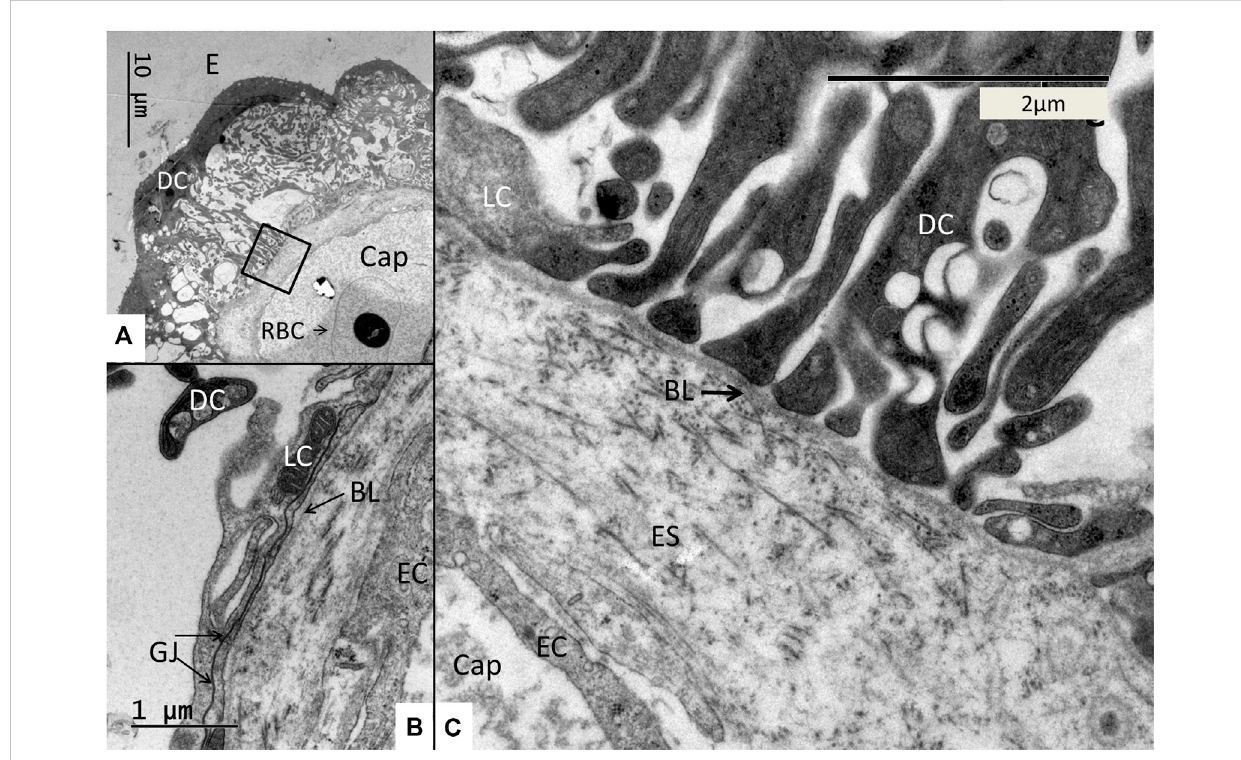
FIGURE 10 (A) Medium-power electron micrograph showing the SV epithelium closely associated with an intra-epithelial capillary. The capillary contains a nucleated red blood cell (RBC). Framed area is magni fi ed in (C) . (B) Higher magni fi cation shows the pericapillary region with light cells (LC) adhering to a thin basal lamina (BL). The light cells are connected with extensive gap junctions (GJ). There is a space between the endothelial cells (EC) and the basal lamina (BL). This space contains connective tissue fi bers. (C) Higher magni fi cation shows podocyte-like, dark cells (DC) projections adhering to the basal lamina (BL) and light cells (LC) surrounding the capillary (Cap) endothelium. There is a space containing extra-cellular matrix and thin connective tissue fi bers around the endothelium. E; Endolymph. ES; Extra-cellular